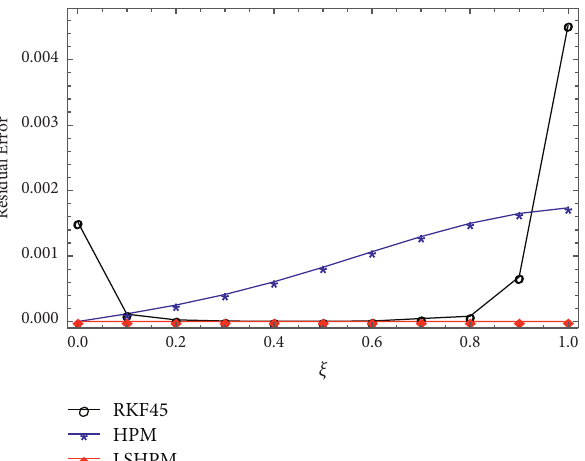
Figure 3: Comparison of errors for RKF45, HPM, and LSHPM when R � 0 . 5 ,M